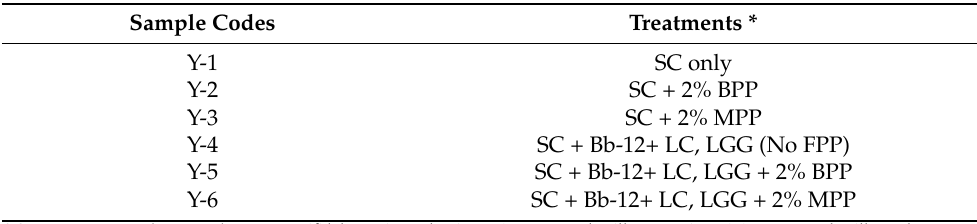
Table 1. Formulation of yogurt